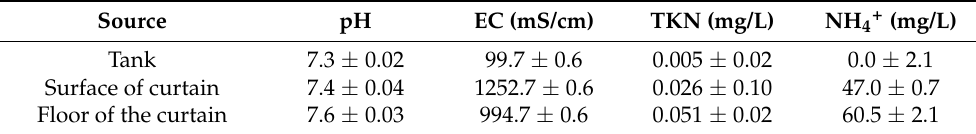
Table 1. Characteristics of sprayed water.